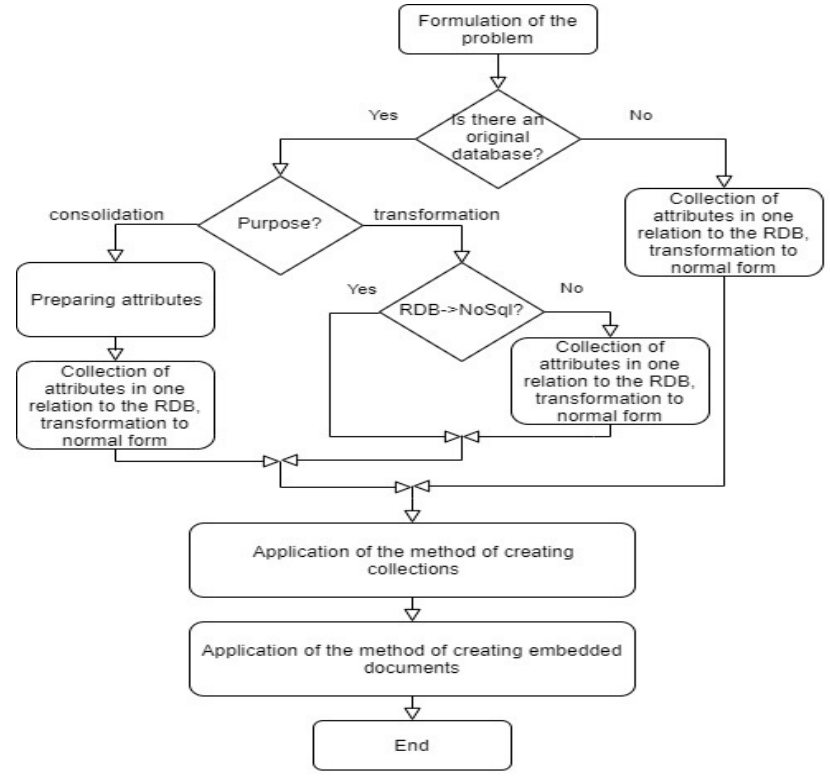
Figure 1. The scheme of creating input data for applying the method of building embedded documents.